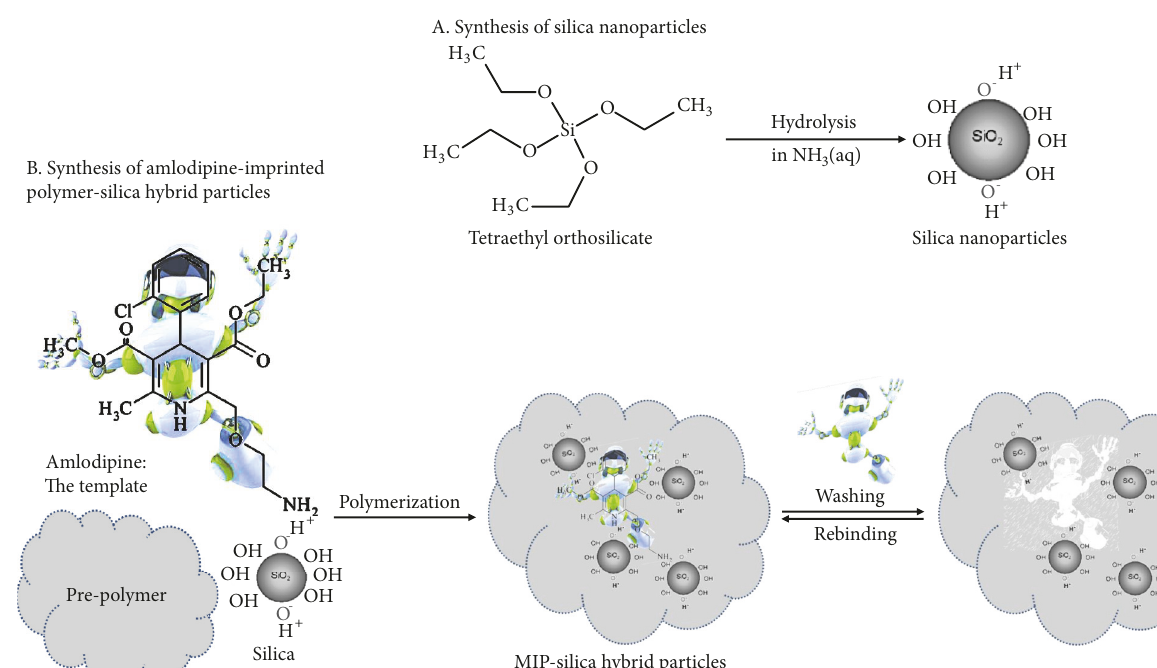
Figure 1: A schematic representation of the formation of MIP-silica hybrid